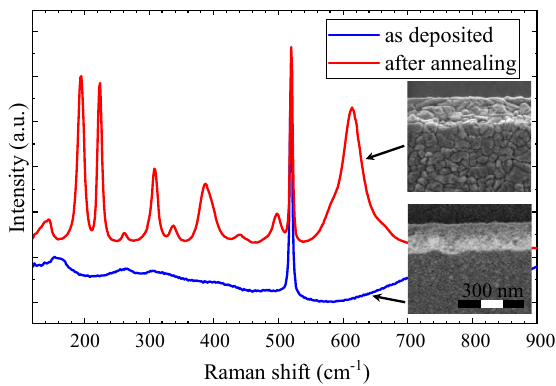
Fig. 3. Raman spectra of VO 2 film on Si: as deposited and after annealing. The insets show SEM images of the respective films.